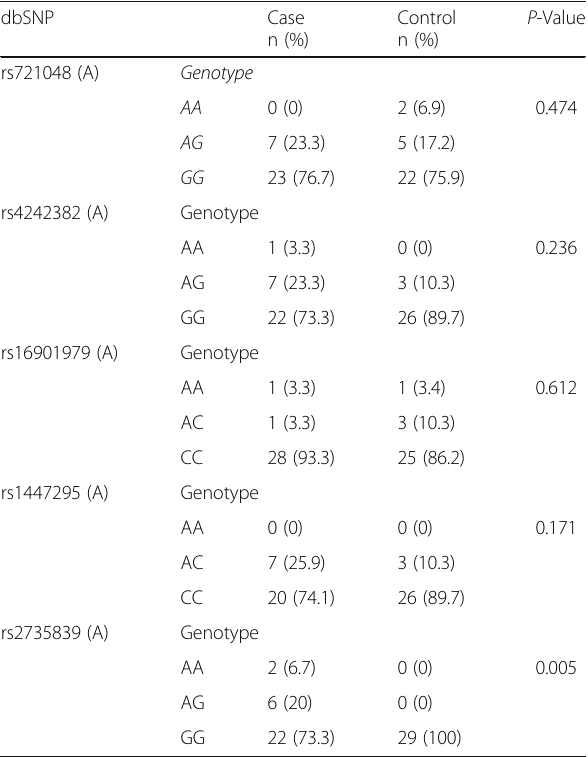
Table 2 Genotype frequency of polymorphisms in both